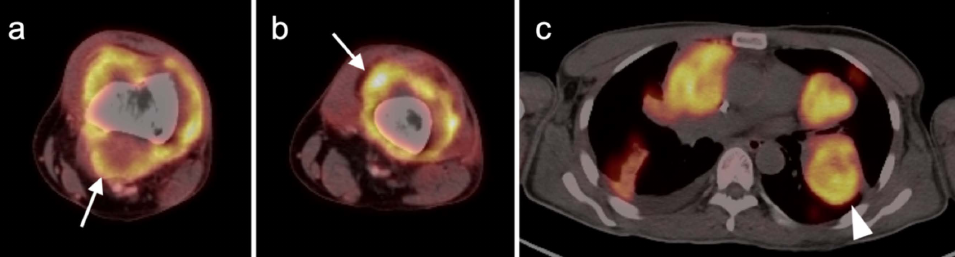
Figure 34. Osteosarcoma of the left distal femur with lung metastases. ( a , b ) Axial FDG PET-CT of the left distal femur shows a hypermetabolic mass (white arrows) primarily within the soft tissues surrounding the sclerotic bone. The patient had recently completed neoadjuvant chemoradiation therapy (CRT) for an osteosarcoma of the left distal femur, with poor treatment response. ( c ) Multiple cannon ball, intensely hypermetabolic lung metastases (white arrowheads) are present on an axial FDG PET-CT of the chest. Pre-CRT, the lung metastases were very